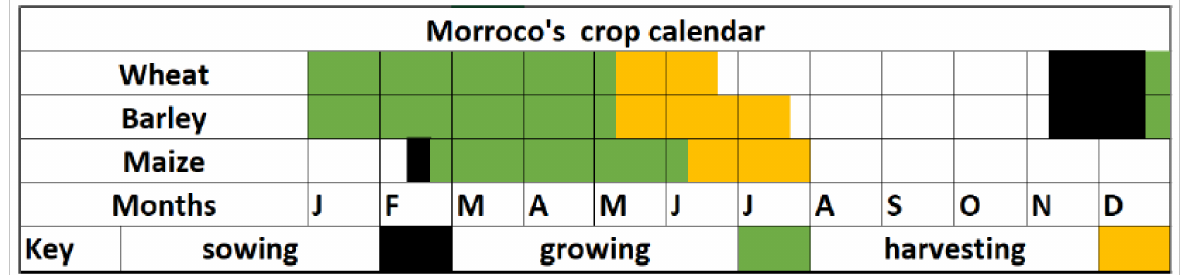
Figure 3. Crop calendar for wheat, barley, and maize in